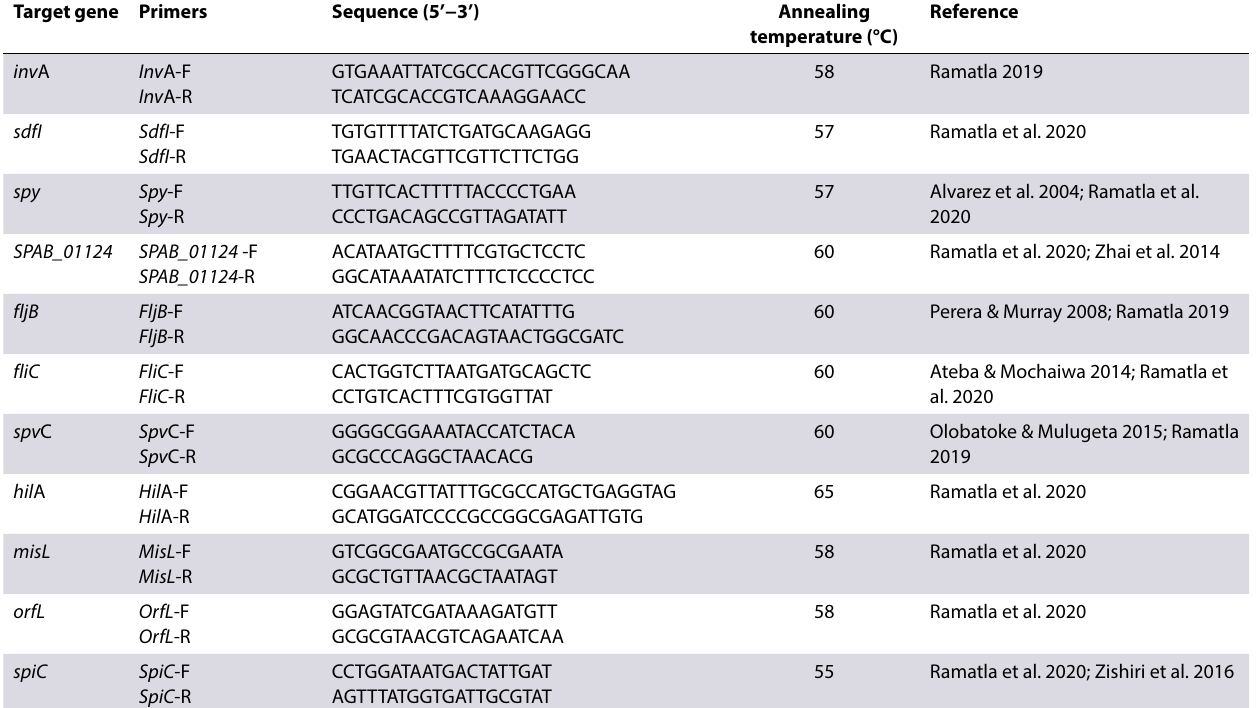
Table II: List of primers and annealing temperatures used for Salmonella